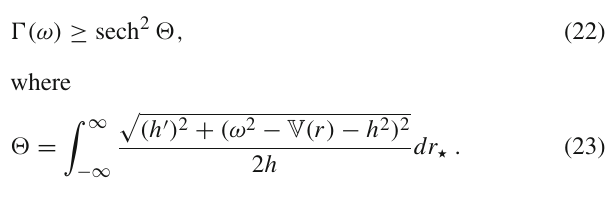
Fig. 5 In the above figure the surface gravity in a deformed spacetime is plotted with respect to varying a with different η . We have set the other parameter at r s = 1